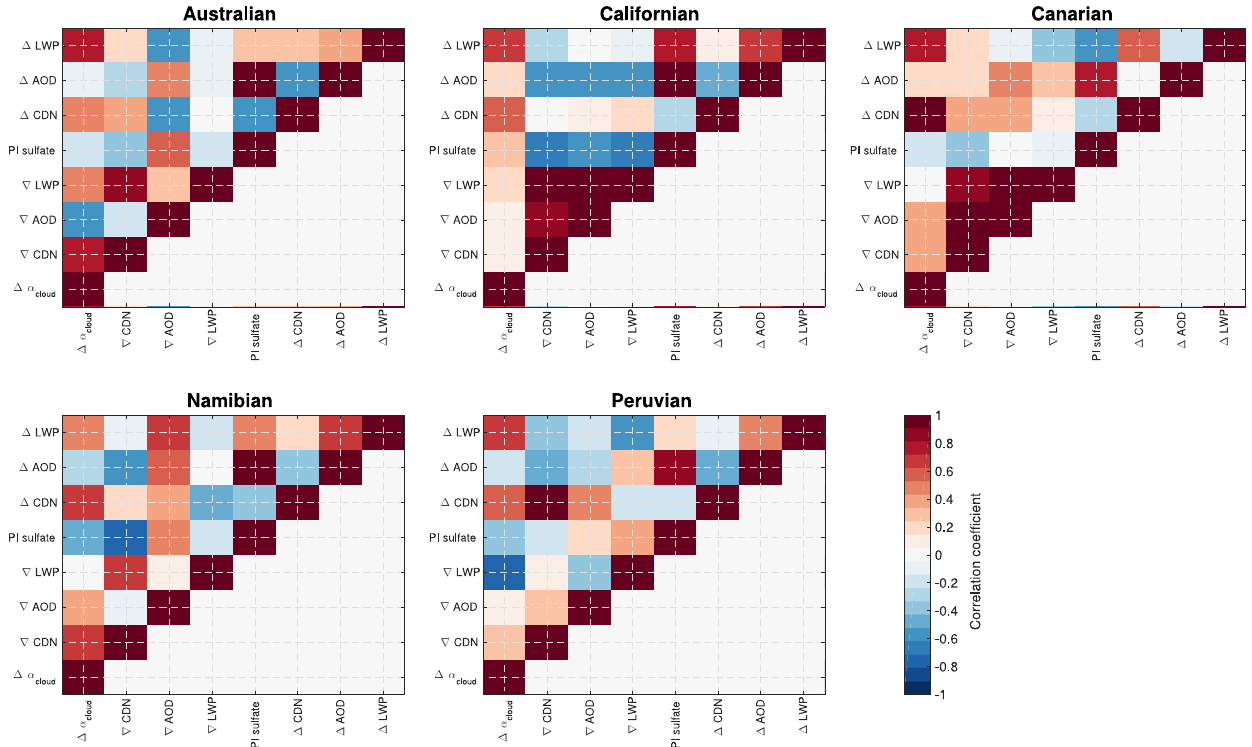
Figure 7. Correlation matrices for the Australian, Californian, Canarian, Namibian, and Peruvian regions. Regional mean changes in cloud albedo between control and all-aerosol experiments ( (cid:49)α cloud ) are related to corresponding changes in CDN, AOD, and LWP ( (cid:49) CDN, (cid:49) AOD, and (cid:49) LWP, respectively), to pre-industrial sulfate load (PI sulfate), and to gradient strength (month-to-month sensitivity) of CDN, AOD, and LWP in the control case ( ∇ CDN, ∇ AOD, and ∇ LWP, respectively) for five CMIP5 models. IPSL does not provide CDN fields and is excluded from the correlation